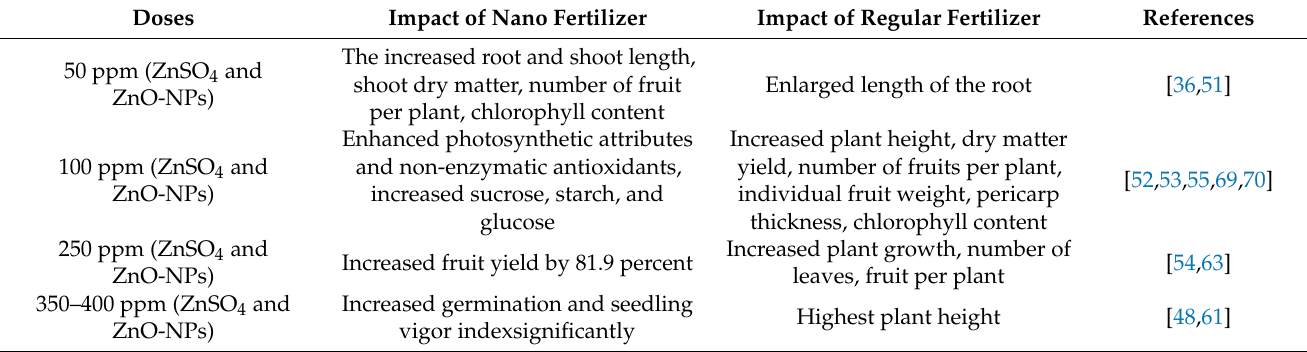
Table 2. Comparing the results of nanofertilizers and regular fertilizers when applying similar doses of nutrients. Doses Impact of Nano Fertilizer Impact of Regular Fertilizer 50 ppm (ZnSO 4 and